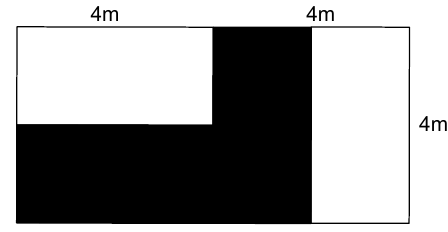
Figure 4: Test Target of uniform